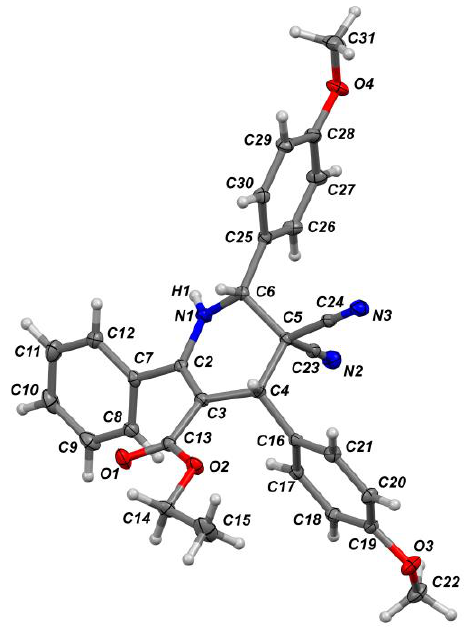
Figure 1. X-ray structure of the 4r 4 SR ,6 RS configuration.